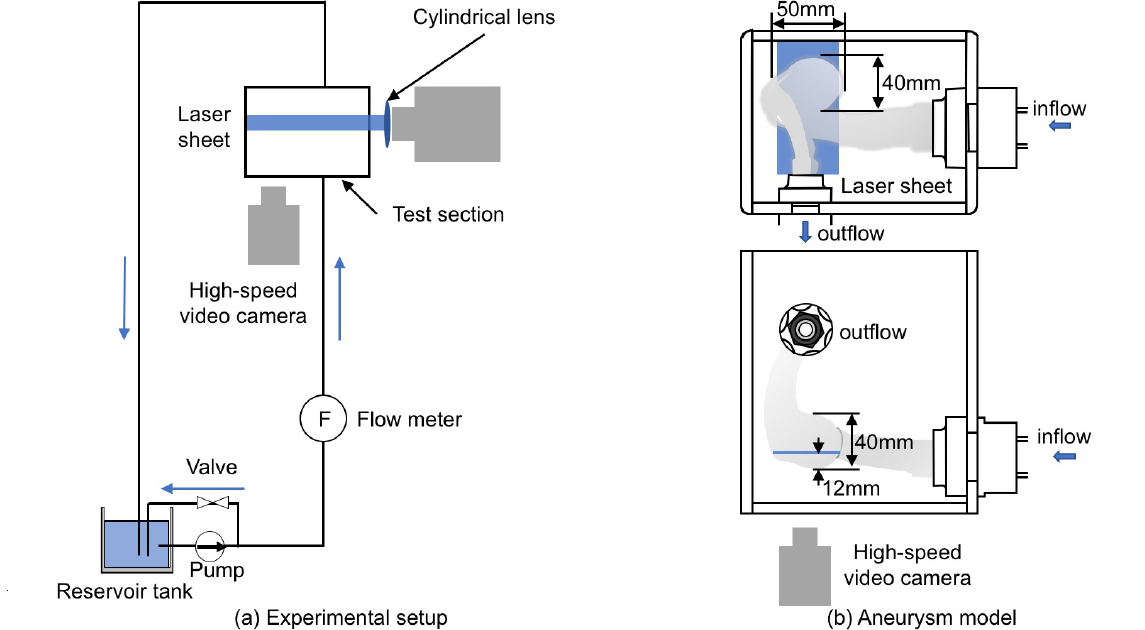
Figure 5. Experimental equipment. ( a ) experimental setup; ( b ) aneurysm model made using 3D